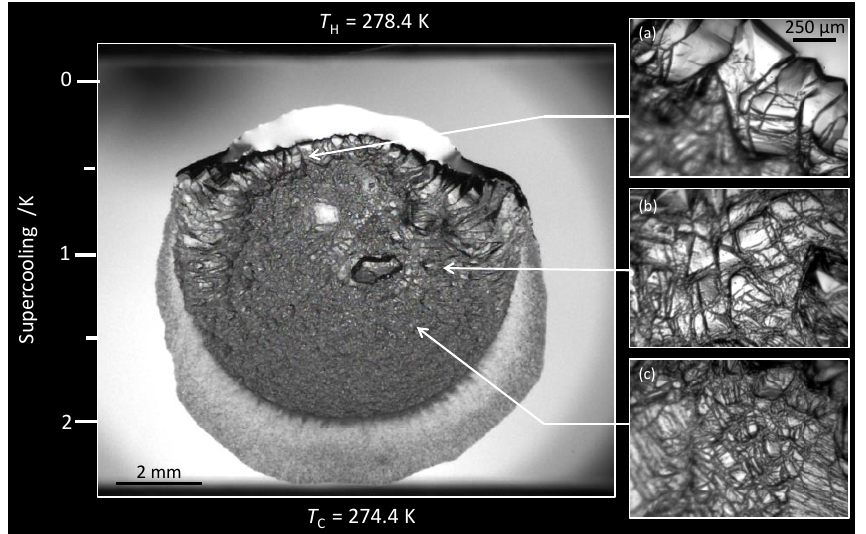
Figure 9. Detail of methane hydrate morphology on an aqueous NaCl solution droplet, subject to a temperature gradient. w NaCl = 5.44%, p = 5.39 MPa, T L = 274.4 K, T H = 278.4 K, and T HLV = 277.6 K. ( a ) Big faceted crystals. ( b ) Granular crystals. ( c ) Smaller granular